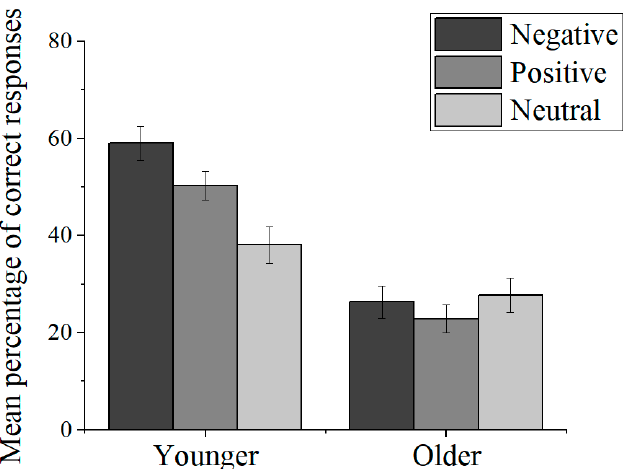
Figure 2. Mean percentage of correct responses (corrected recognition scores: correctly recognized items (HITs)-false alarms (FAs) for pictures) by valence for younger and older adults (with standard error bars).